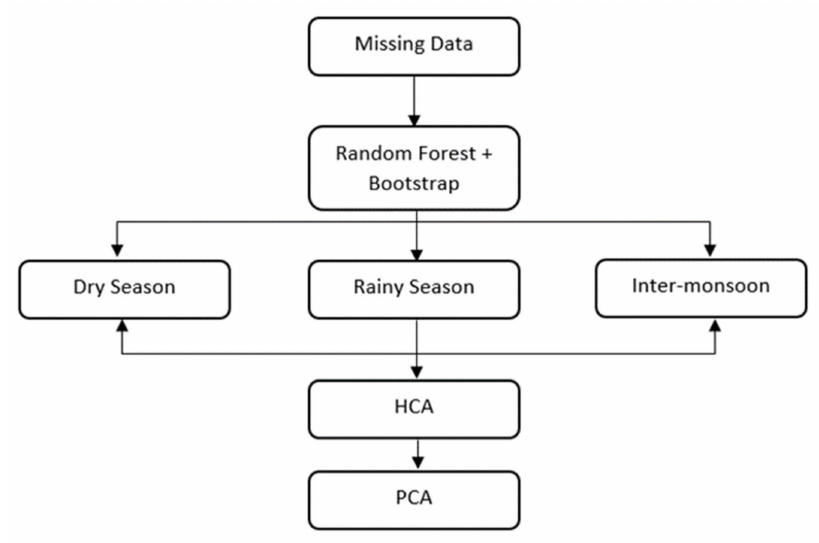
Figure 3. Methodological flow of identifying regionalization rainfall regimes using Hybrid RF-Bs couple with multivariate approaches.